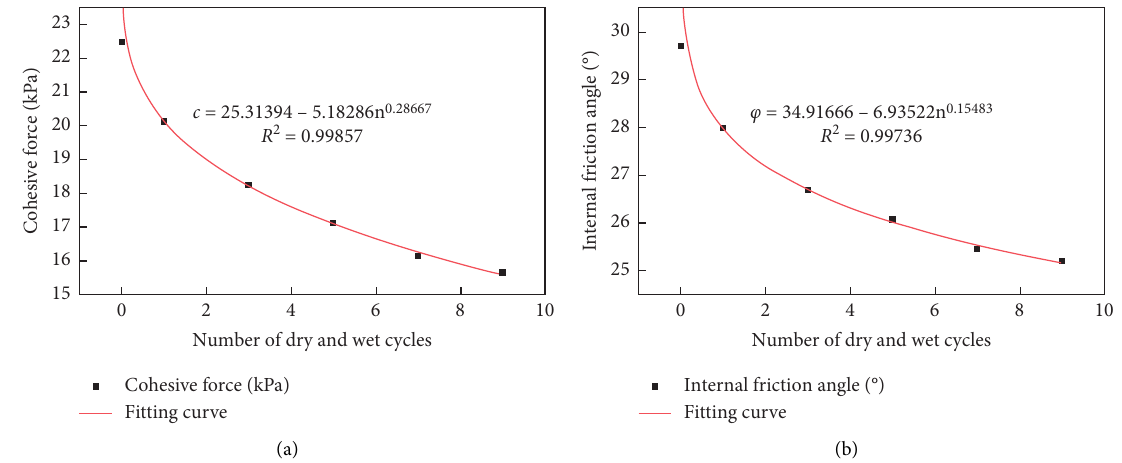
Figure 16: Fitting result between c and φ and number of dry and wet cycles.